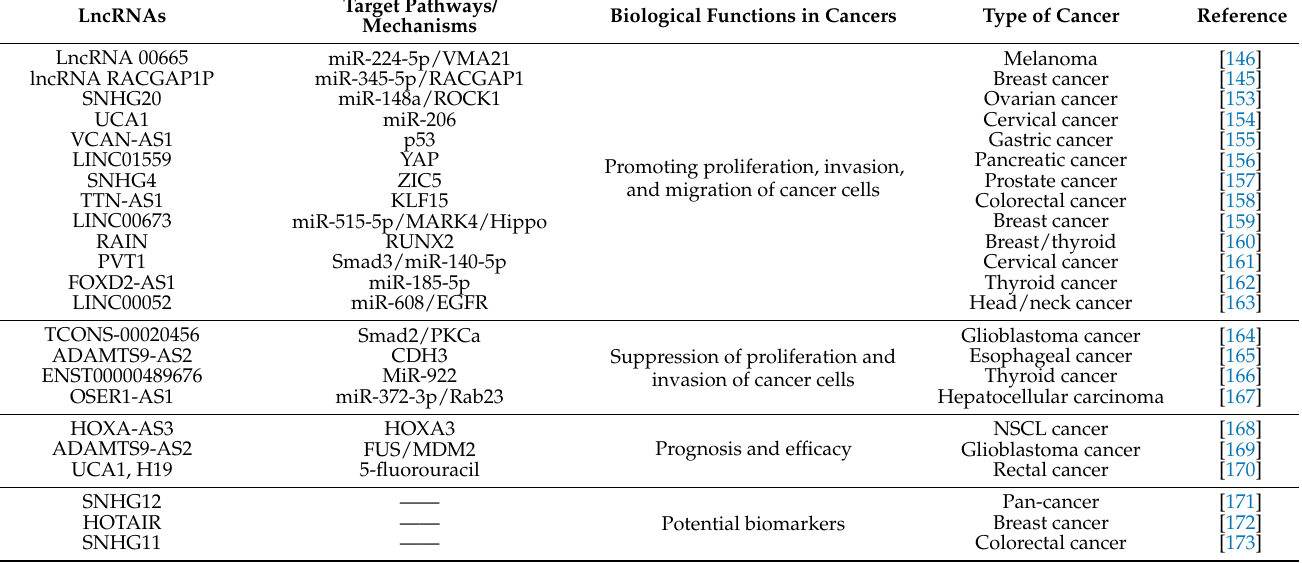
Table 1. Biological functions of lncRNAs in